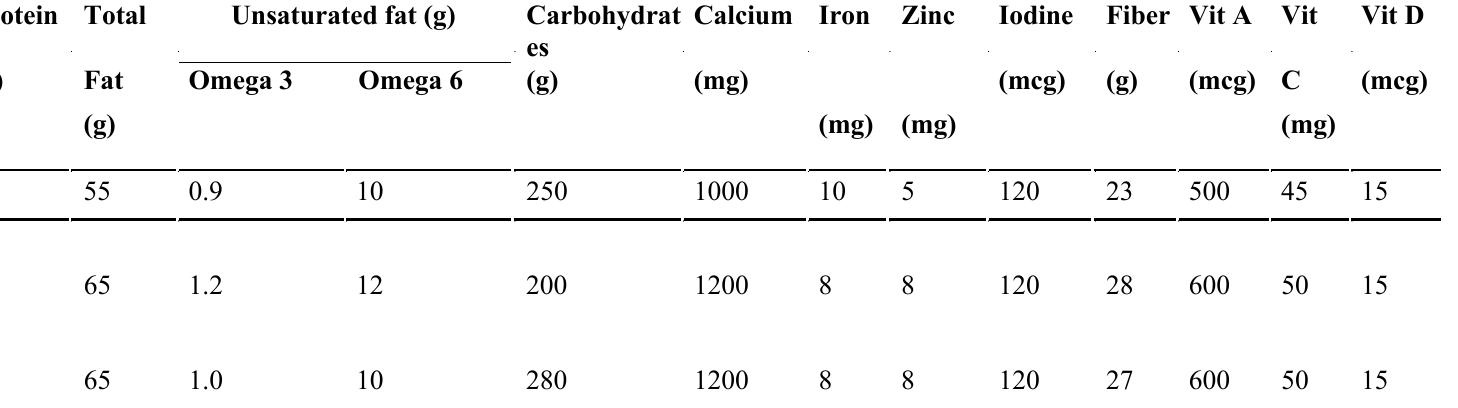
Table 2 . Iron and zinc content in food ingredients Nutrien ts Nutrien t Nutrient